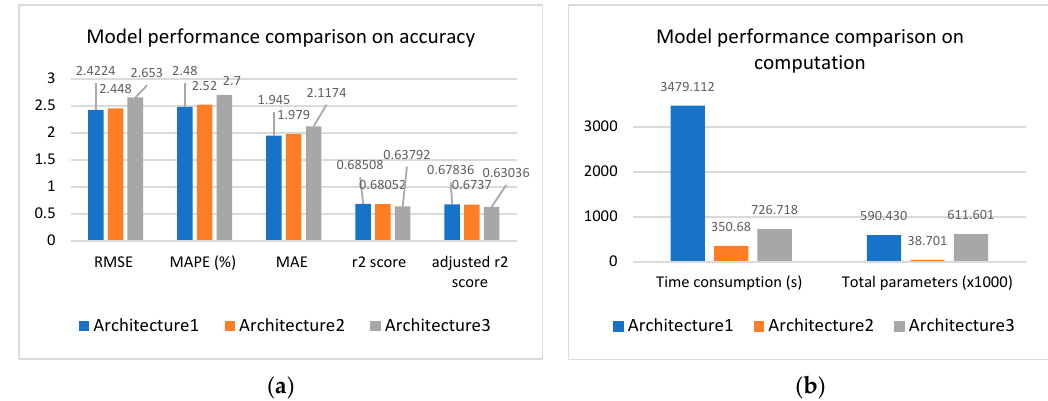
Figure 16. GRU model performance comparison on different architectures: ( a ) the accuracy comparison on different architectures; ( b ) the computation cost comparison on different architectures.